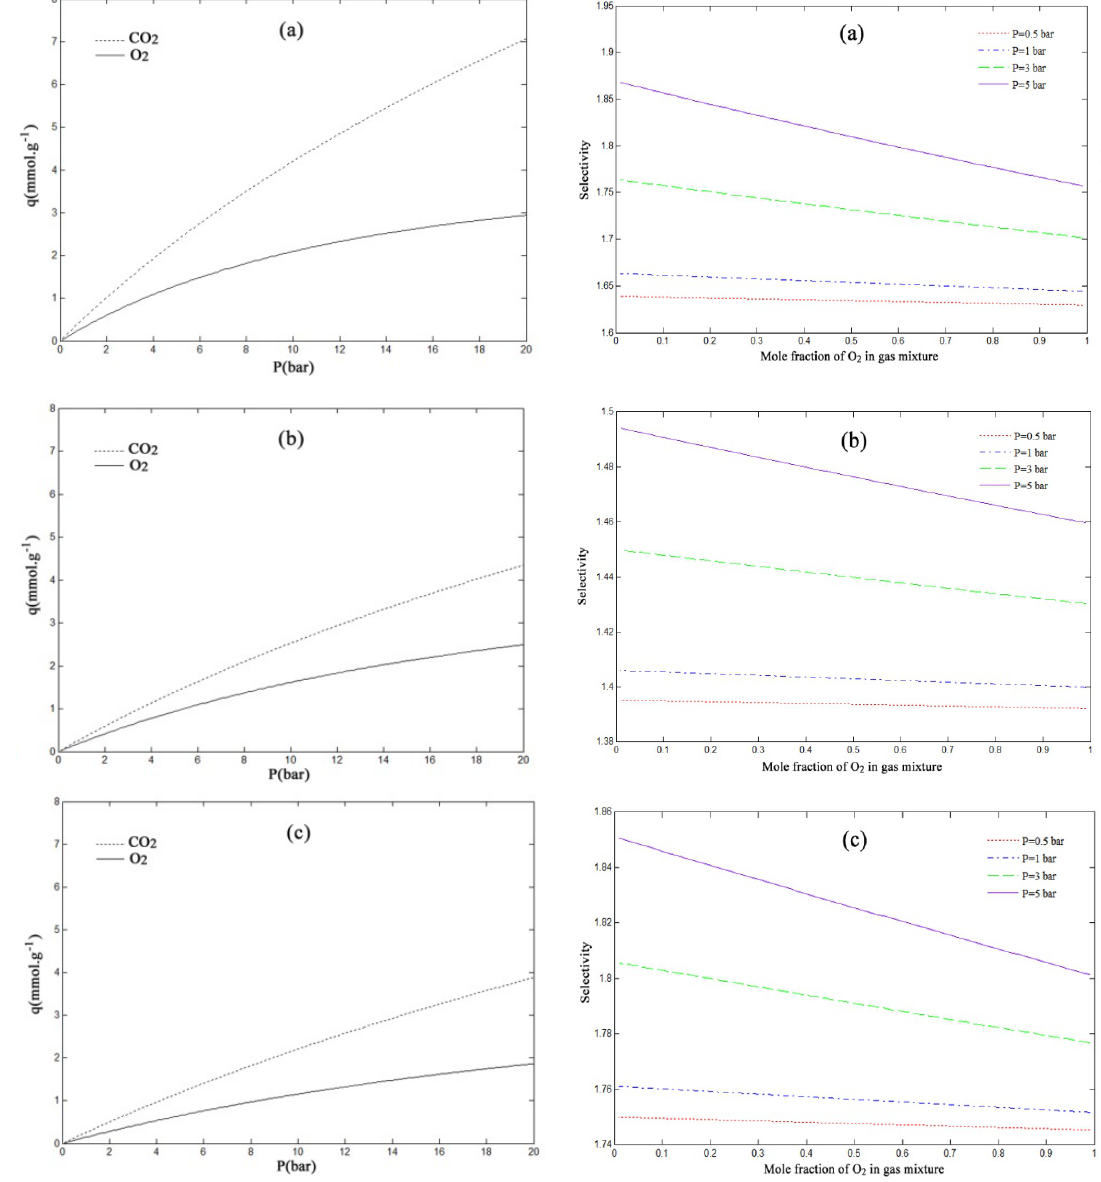
Fig.9. Binary adsorption isotherms for 50:50 gas-phase CO 2 /O 2 mixtures predicted by IAST at different pressures and temperatures. Fig. 10. Ideal selectivity of CO 2 to O 2 adsorbed on MWCNT at different temperature and different pressure for 50:50 gas-phase. Table 1 Langmuir and Freundlich isotherm constants for adsorption of CO 2 and O 2 on MWCNT